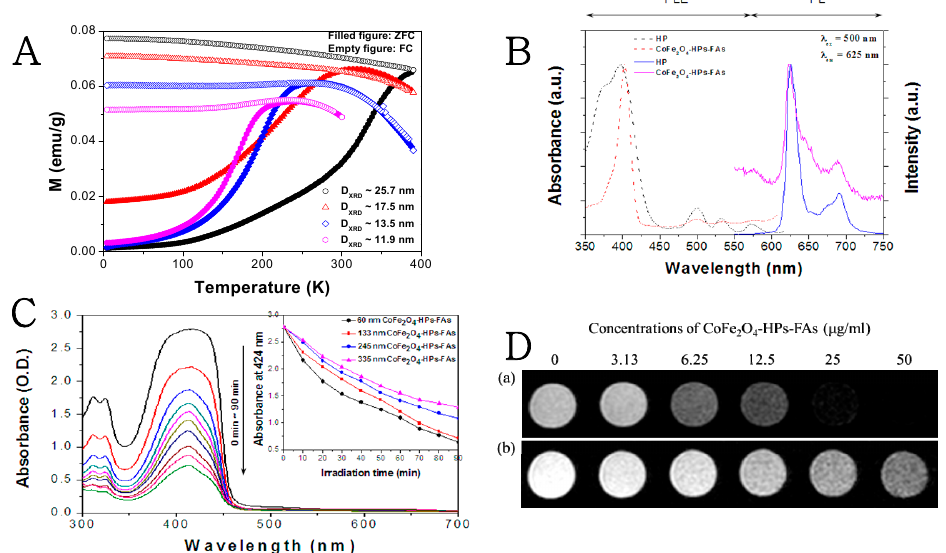
Figure 2. Magnetic and optical properties of multifunctional magnetic particles: ( A ) Temperature dependence of magnetic susceptibility of monodispersed CoFe 2 O 4 particles in zero-field cooled (ZFC) and field-cooled (FC) conditions measured using a SQUID magnetometer at an applied field of 5 kOe; ( B ) PL and PLE spectra of pure HP and CoFe 2 O 4 -HP-FA in THF. The excitation and detection wavelengths were 500 and 625 nm for PL and PLE spectra, respectively; ( C ) Irradiation time-dependent UV-Vis spectra of DPBF in THF solution with CoFe 2 O 4 -HP-FA excited by the Xe lamp. The inset represents the absorption OD of DPBF in THF at 435 nm as a function of irradiation time. In the inset, (a) DPBF only with the light, (b) DPBF with CoFe 2 O 4 -HP-FA without the light, and (c) DPBF with CoFe 2 O 4 -HP-FA with the light are shown; ( D ) MR (T 2 -weighted) images of CoFe 2 O 4 -HP-FA and PC-3 cells treated with CoFe 2 O 4 -HP-FA. (a) Different concentrations of 60-nm CoFe 2 O 4 -HP-FA. (b) PC-3 cells treated with 60-nm CoFe 2 O 4 -HP-FA. Cells treated with different concentrations of 60-nm CoFe 2 O 4 -HP-FA were incubated for 2 h in the dark before acquisition of MR images. Using a wet chemical process, size-controlled CoFe 2 O 4 particles were easily bonded with HP